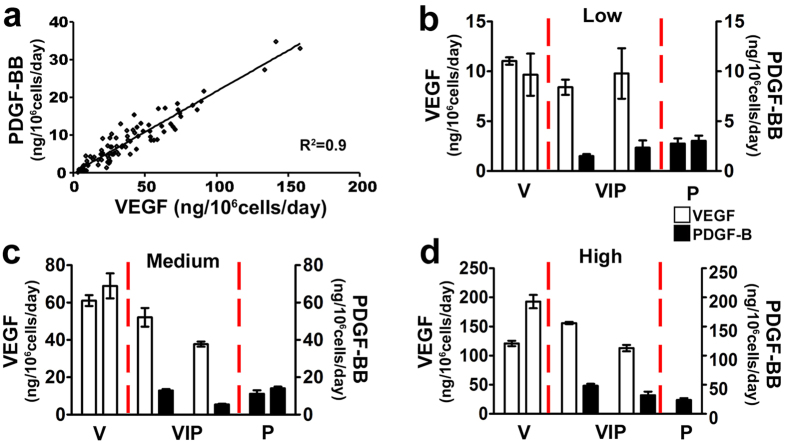
Balanced VEGF and PDGF-BB expression by VIP myoblast clones and selection of clone families.(a) Correlation between in vitro production of VEGF164 and PDGF-BB (in ng/106 cells/day) in 90 individual myoblast VIP clones, co-expressing the two factors from a single bicistronic retroviral vector. The relative levels were linearly correlated in each clone (R2 = 0.9). (b–d) Based on their in vitro production of VEGF and/or PDGF-BB, 6 VIP clones were paired to 6 V clones and 5 P clones, expressing only VEGF and PDGF-BB respectively, in 3 different groups of increasing expression levels (Low, Medium and High). Data are shown as mean ± SEM (n = 4/clone).